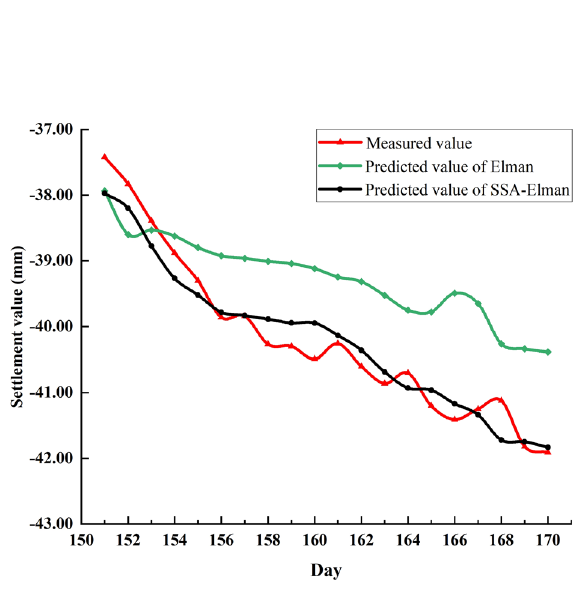
Figure 11. Elman, SSA-Elman predicted value and measured values at P2